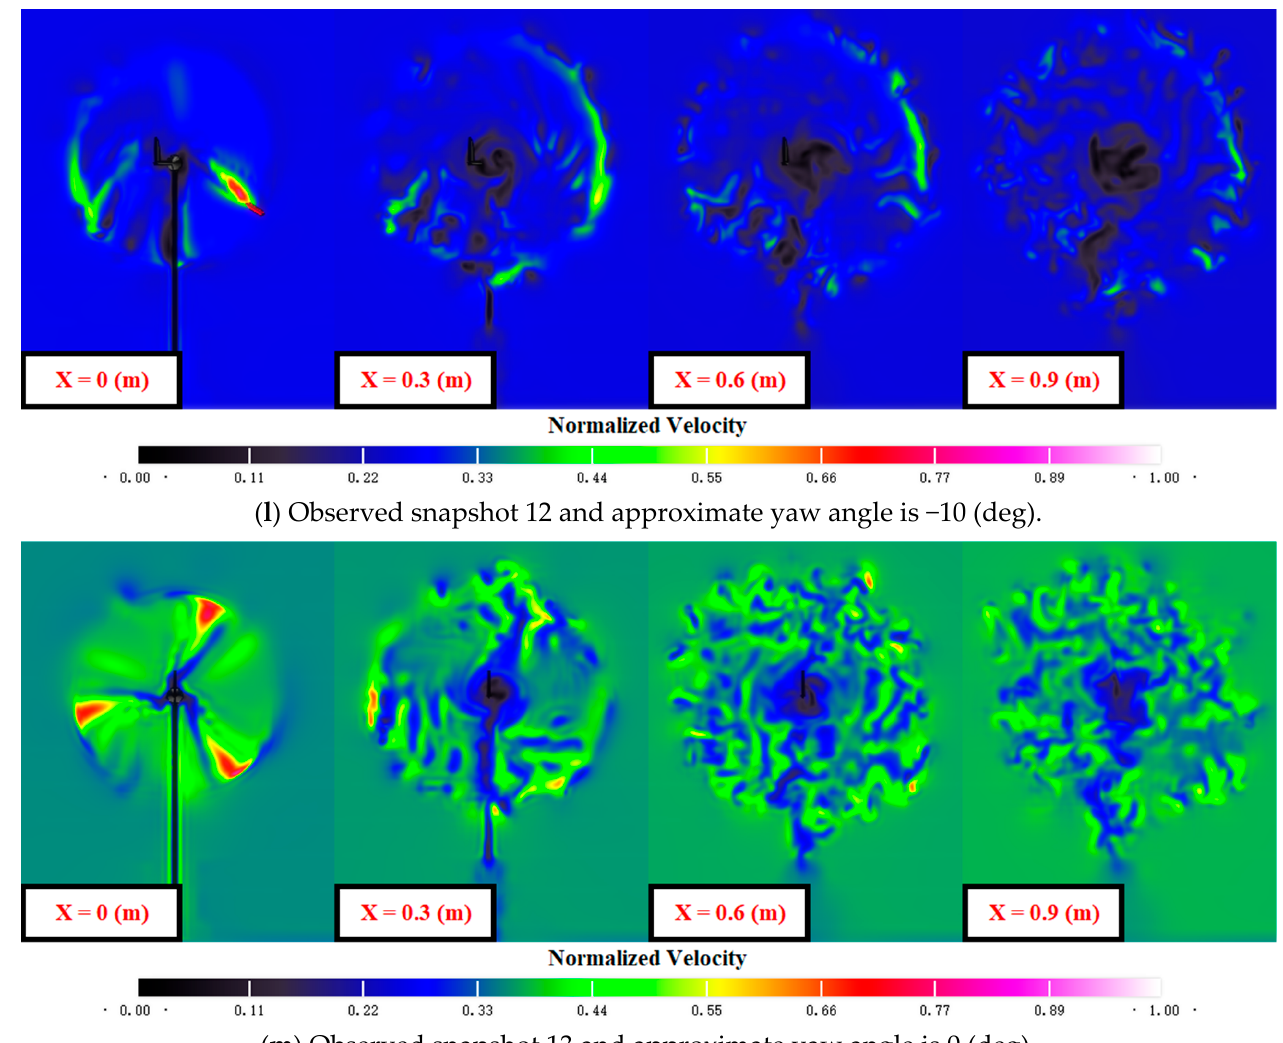
Figure 12. Computational snapshots in the feature surfaces of X = 0 (m), X = 0.3 (m), X = 0.6 (m) and X = 0.9 (m).